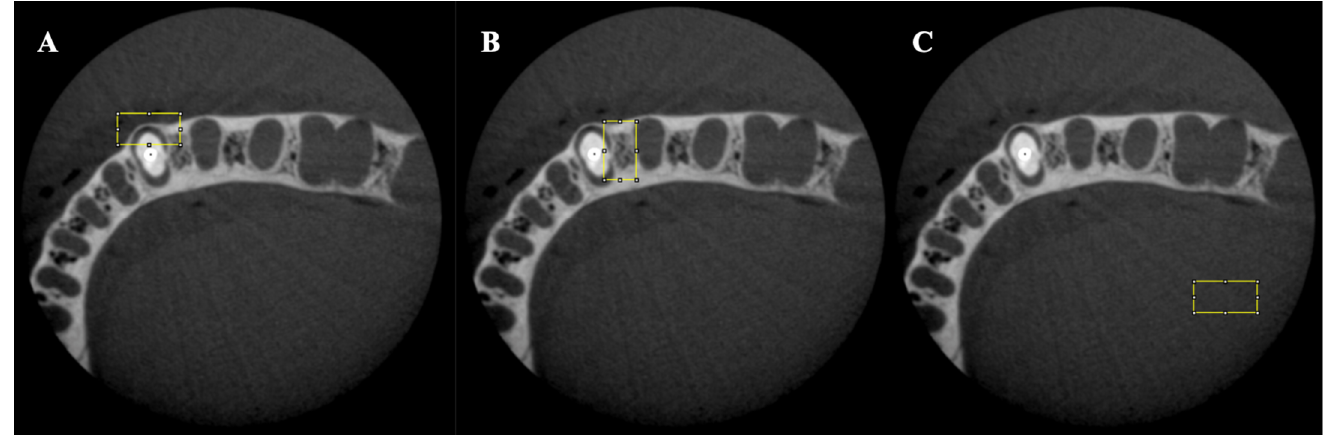
Figure 3. Area of interest for each middle and cervical third: ( A ) buccal area (width 60 × height 30); ( B ) interproximal area (width 30 × height 60); ( C ) control area (width 60 × height 30).